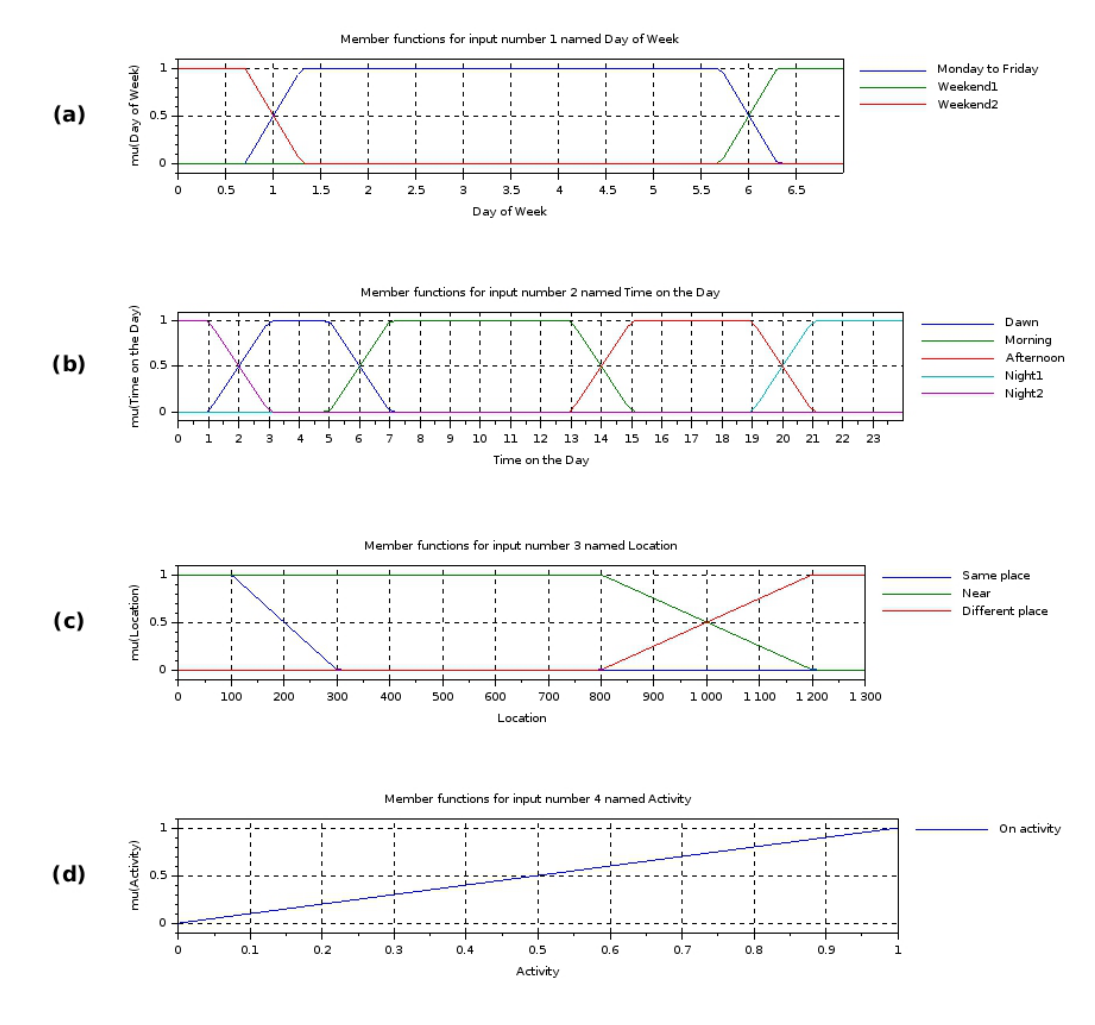
Figure 3. Membership functions of the context information. ( a ) Day of Week; ( b ) Time on the Day; ( c ) Location; ( d )